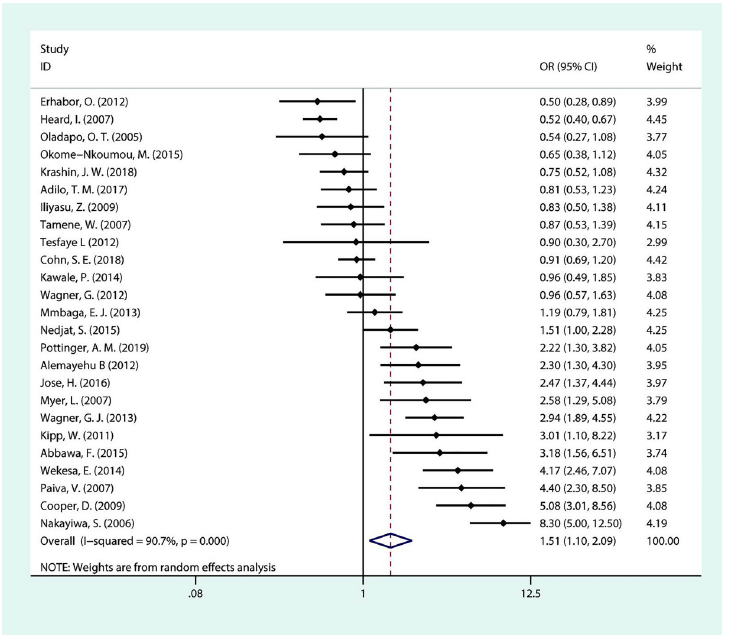
Fig 4. Forest plot of pooled OR for fertility desire in PLHIV (men vs